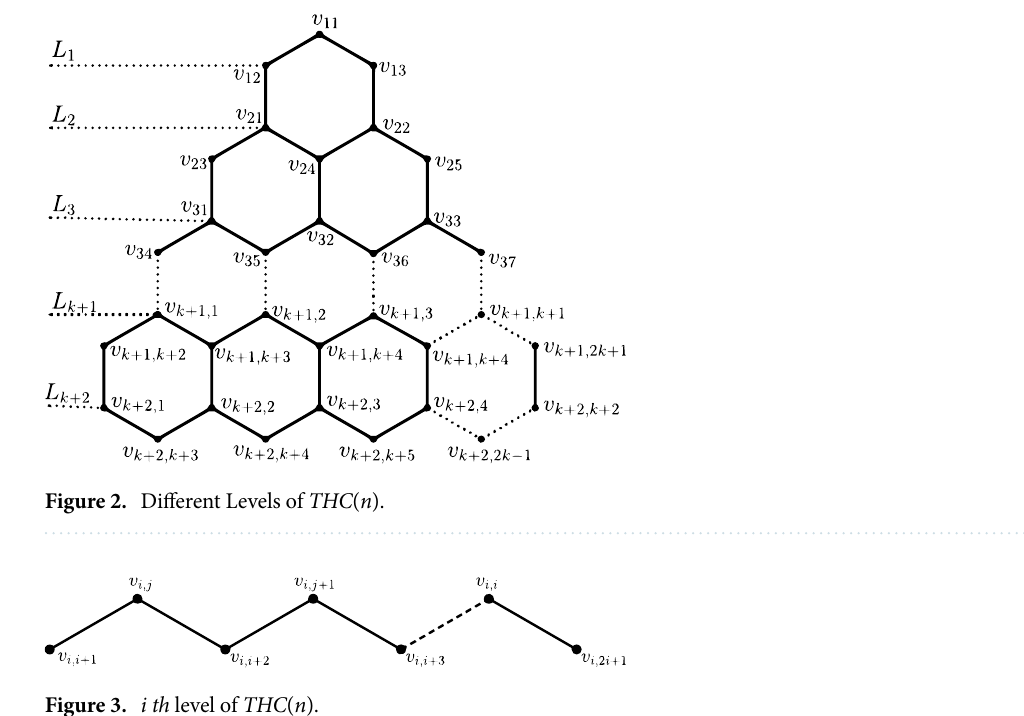
Figure 3. i th level of THC ( n